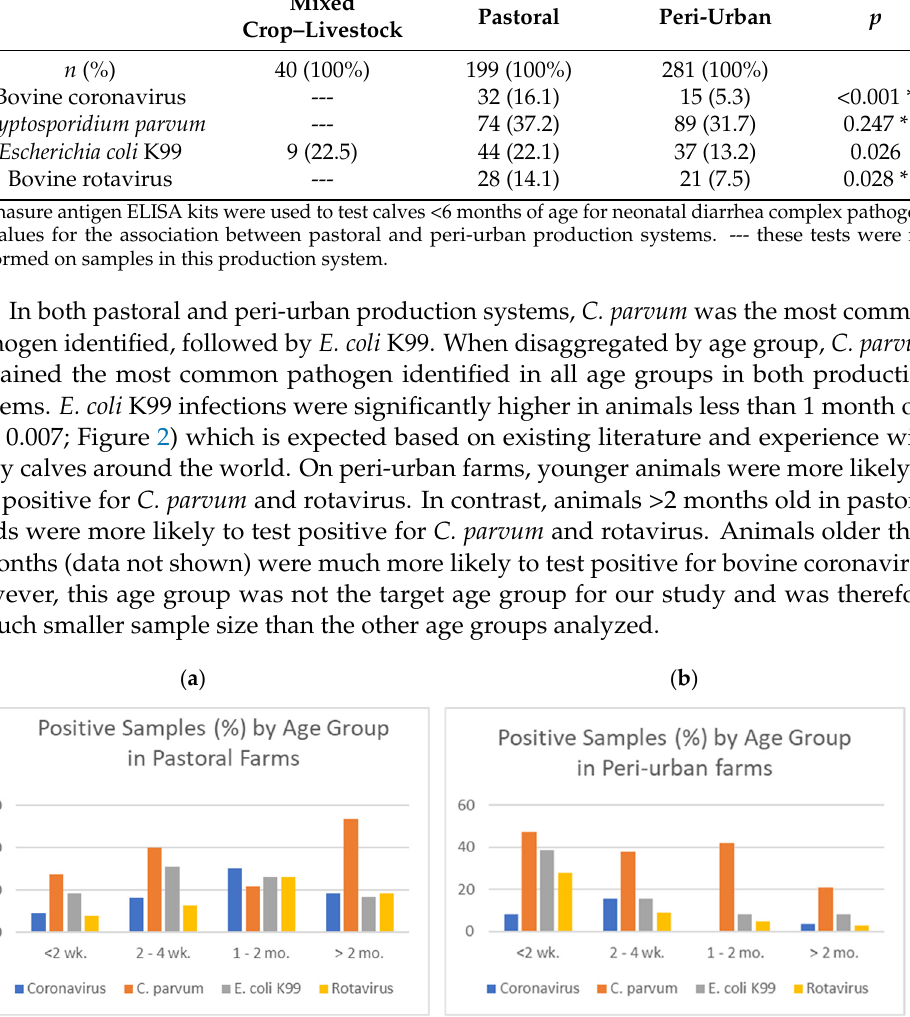
Figure 2. Diarrhea test results by age group in ( a ) pastoral and ( b ) peri-urban production